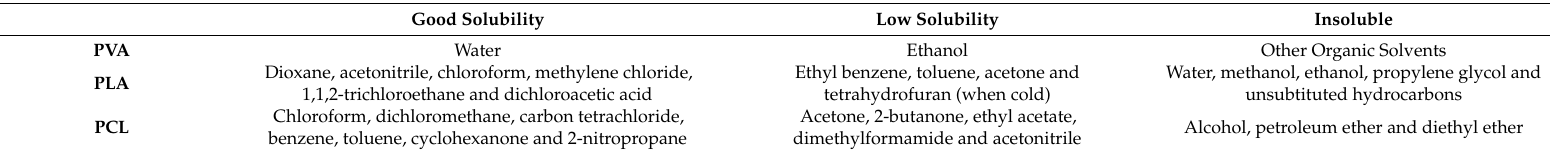
Table 5. Solubility of PVA, PLA and Poly(caprolactone)